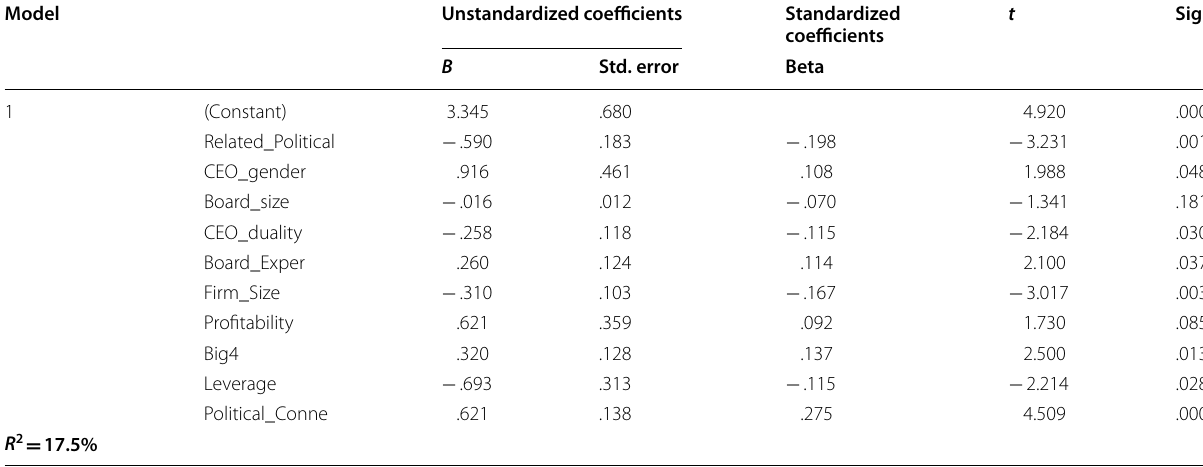
Table 5 Regression results of the impact of political connections on the firm value using related party as a moderating variable